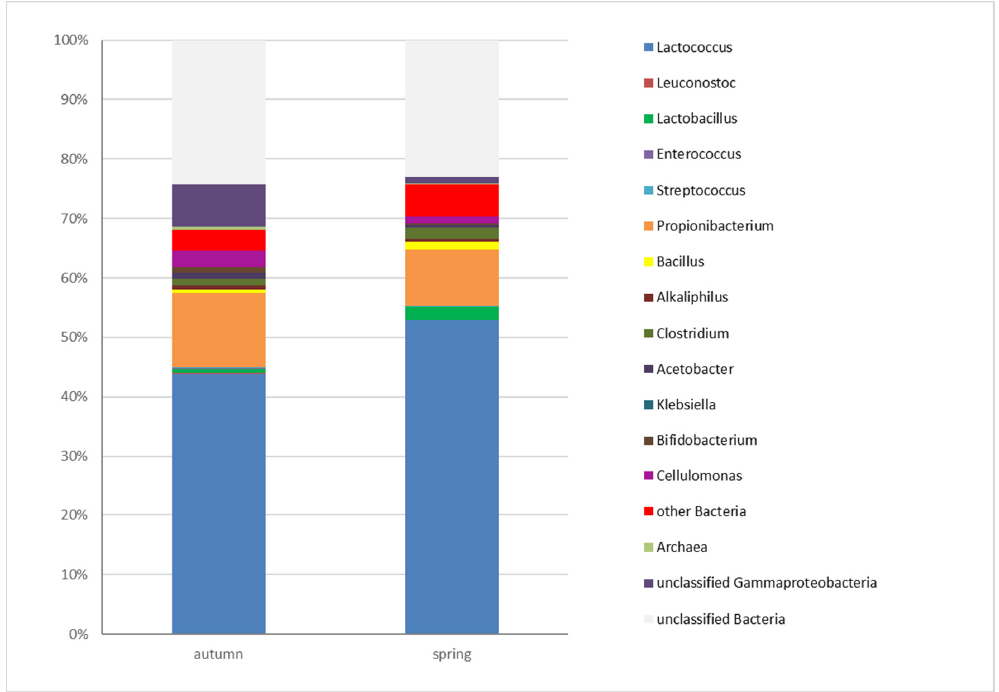
Figure 2. The average relative abundance (%) of the sequences identified at genus level in samples of Edam cheese.